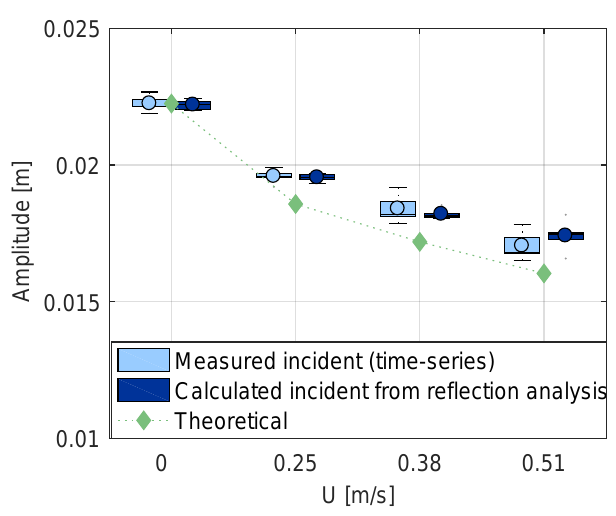
Figure 6. Wave amplitude versus current velocity for 1.6-s regular waves. Box plots represent the variation between five repeats and are shown for two methods of calculating incident regular wave amplitude. Note that for each velocity, two methods/box-plots are shown side-by-side and are not at different